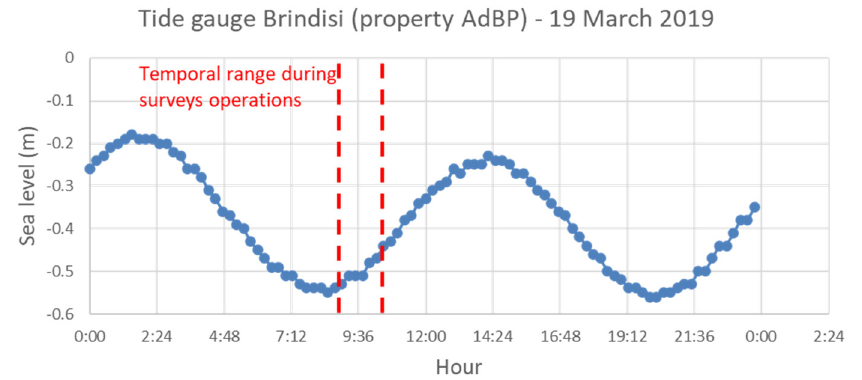
Figure 5. Records from the Brindisi tide gauge (property of AdBP) during the TLS survey on 19 March, 2019.